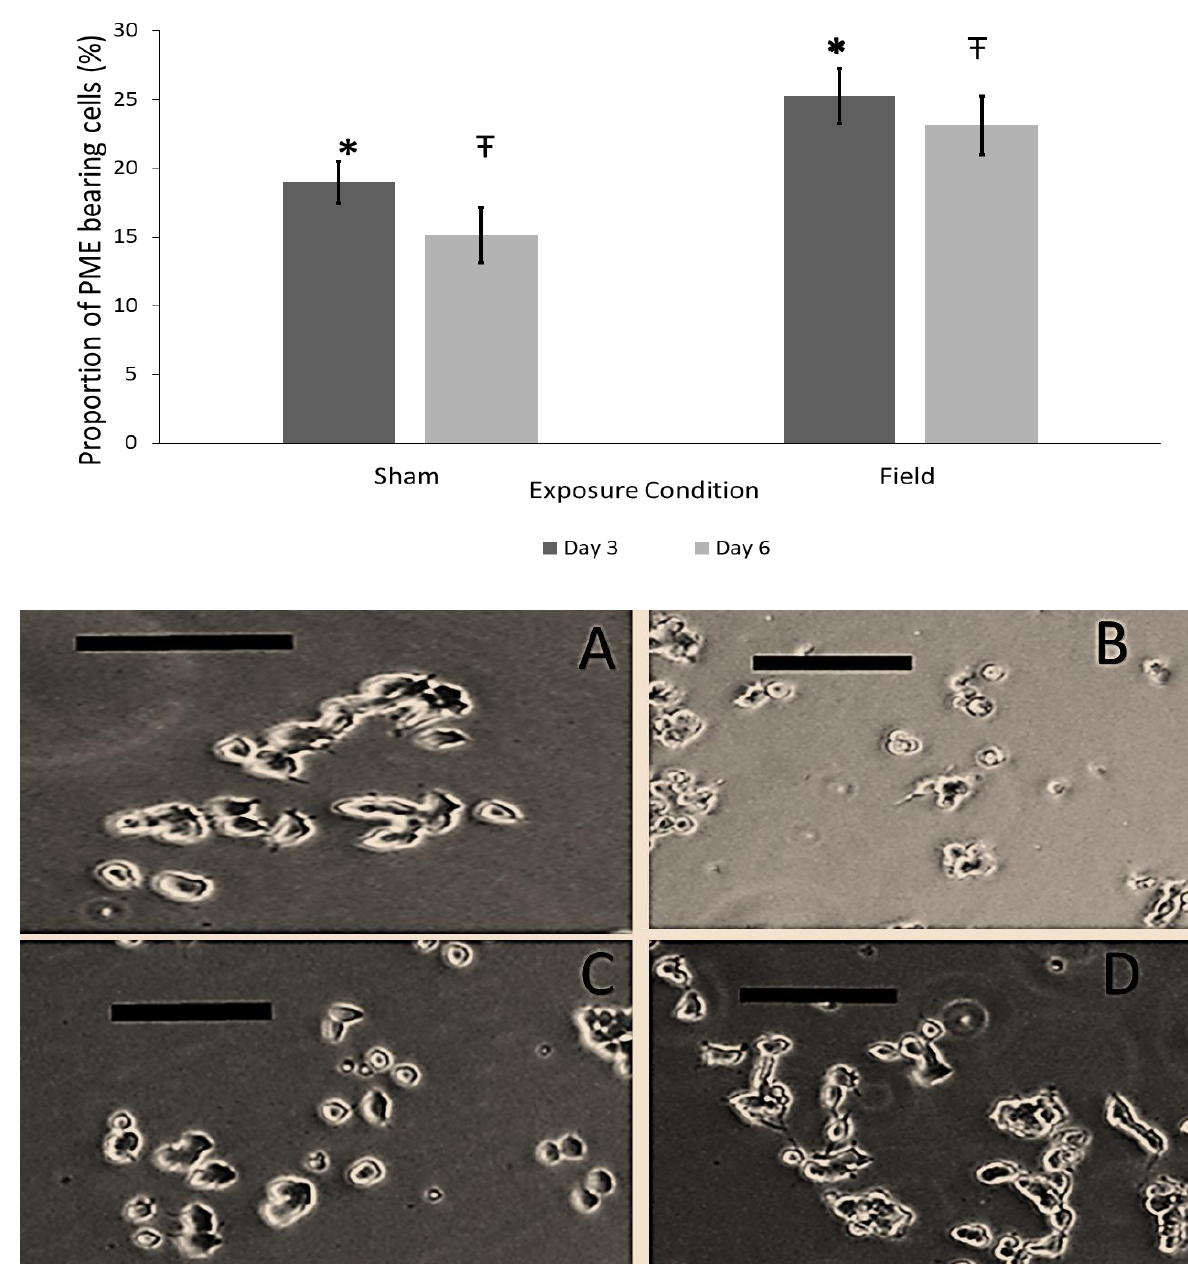
Figure 1. PC12 cells were exposed to the Burst-firing EMF pattern (PD = 3 msec, ISI = 3 msec; peak intensity 40 mG) generated by the 4-D application geometry with 2-Hz spatial rotation across all three axes, treated with 0.5 µ M of forskolin and the proportion of PME-bearing cells determined. Sham treatments serve as the control condition (forskolin only). The graph (upper panel) represents the proportion of PC12 cells bearing PME following the 1-hour Burst-firing EMF or Sham exposures. Error bars represent SEM. * and Ŧ indicate significant differences between conditions ( p < 0.05). Supporting photos show representative samples comparing 1 hour exposures to the Sham condition measured ( A ) 3 days and ( B ) 6 days after exposure and 1 hour exposures to Burst-firing EMF measured ( C ) 3 days and ( D ) 6 days after exposure. Dark bars were fitted to original photos prior to their magnification and adjustment. Darkened bars measure approximately 100 um in length for each individual photo. For each condition there were 2 plates conducted in parallel, 4 sample photos assessed per plate, and all trials were repeated in triplicate.